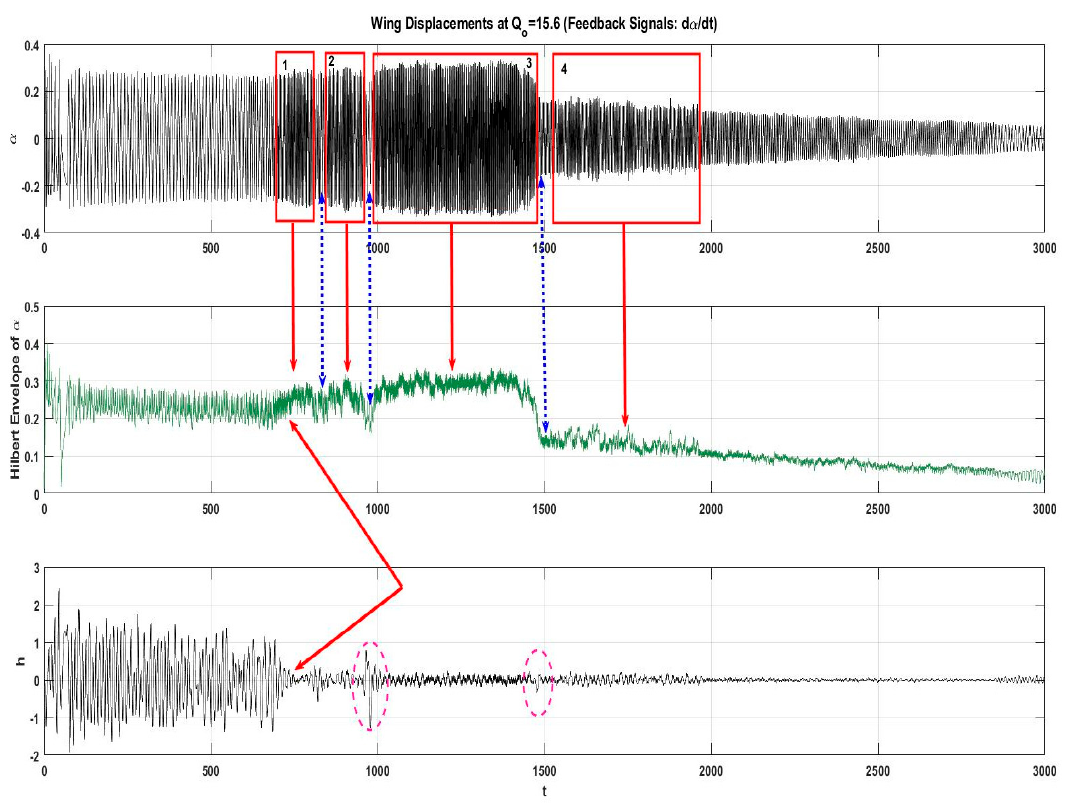
Figure 10. Aeroelastic response with resonance capture cascade ( Q o = 15.6).